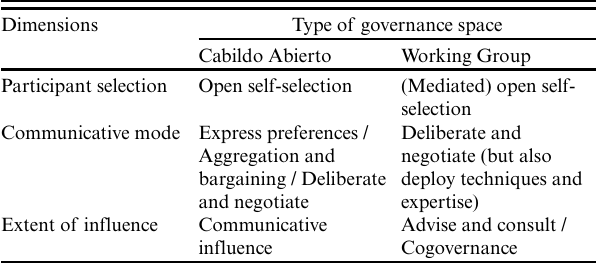
Table 1 . Pinares de Oriente governance spaces mapped using Fung’s democratic cube. Source: the authors.